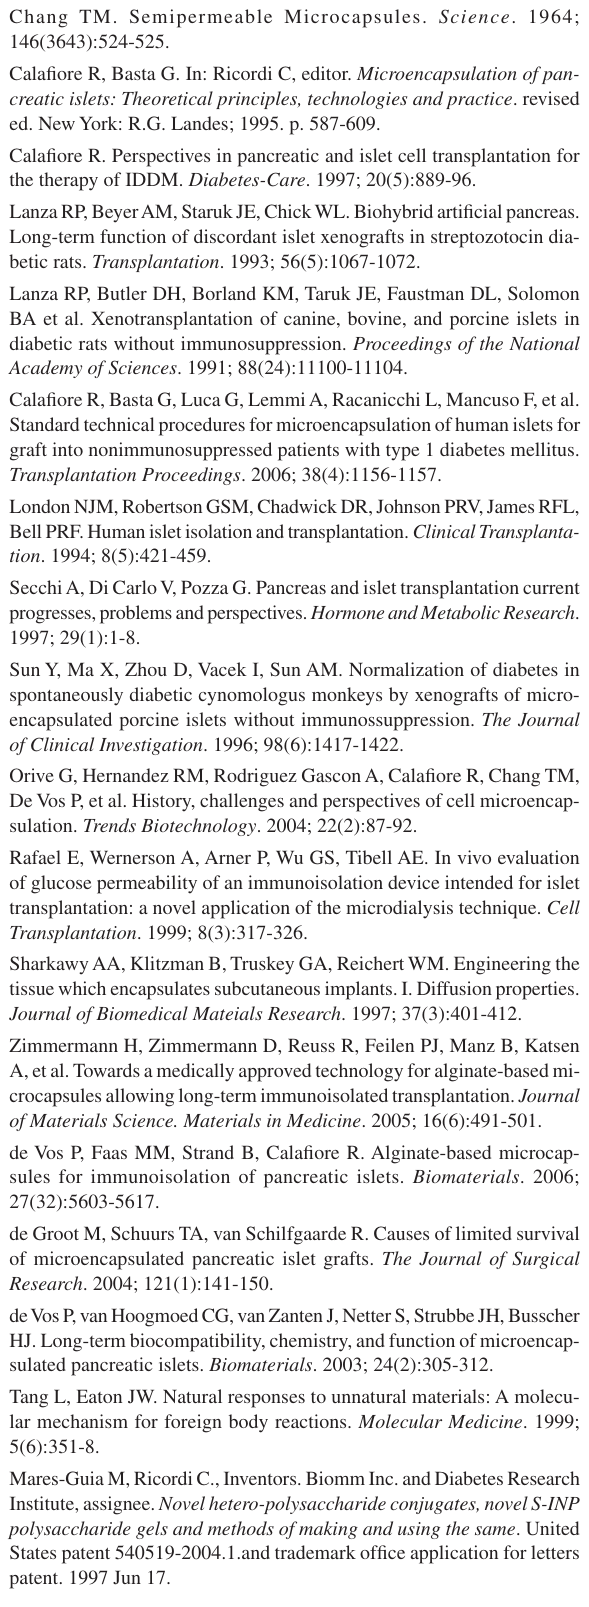
(circle), ALG + BaCl (lozange) and 2 2